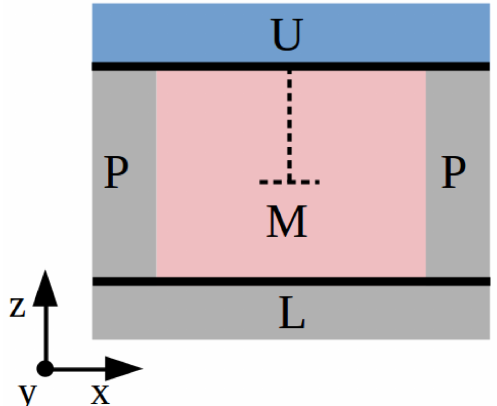
Figure 6. Sketch of the system used to estimate the Peierls stress with Method A . Three main parts are differentiated: the upper part “U”, the lower part “L”, and the region with mobile atoms “M”. “P” indicates application of periodic boundary conditions and the dashed line the orientation of the edge dislocation.